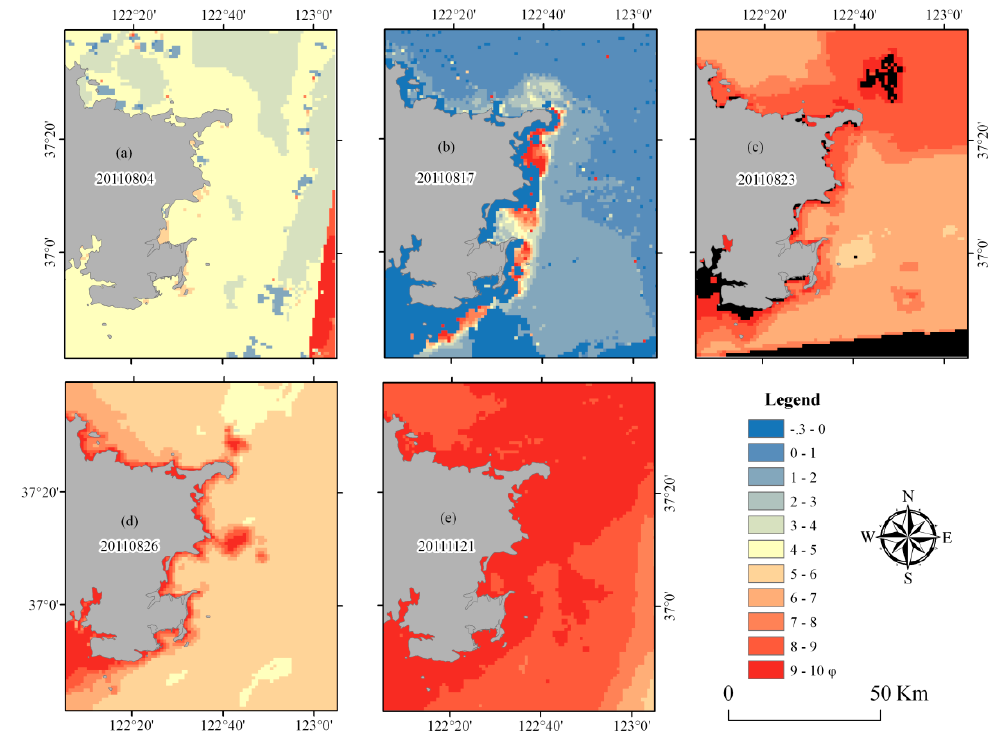
Figure 9. Time series variation characteristics of the average surface particle size (ø) before and after the passage of typhoon Muifa on August 8, 2011.